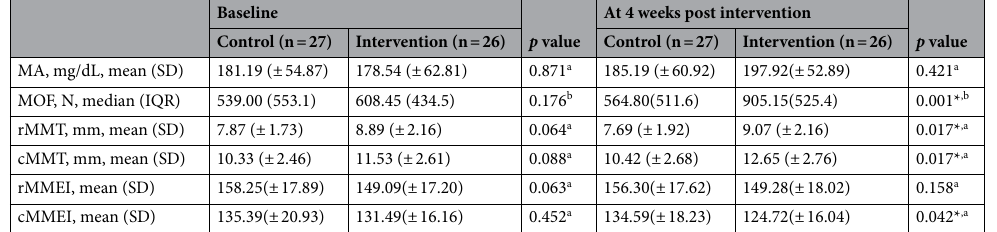
Table 2. Comparison between the control (n = 27) and intervention (n = 26) groups before and after intervention. SD standard deviation, IQR interquartile range, MA masticatory ability, MOF maximum occlusal force, rMMT masseter muscle thickness at rest, cMMT masseter muscle thickness during contraction, rMMEI masseter muscle echo intensity at rest, cMMEI masseter muscle echo intensity during contraction. * p -value < 0.05. a Two-sampled t test. b Mann–Whitney U test.